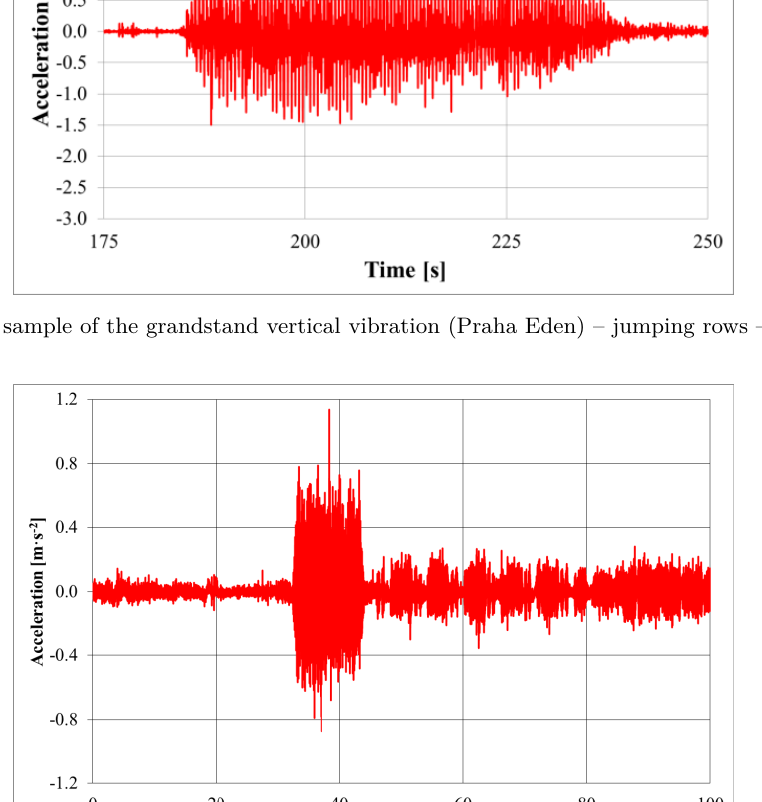
Table 1. Table of occurrence of synchronized jumping crowd during the match – AC Sparta Praha.